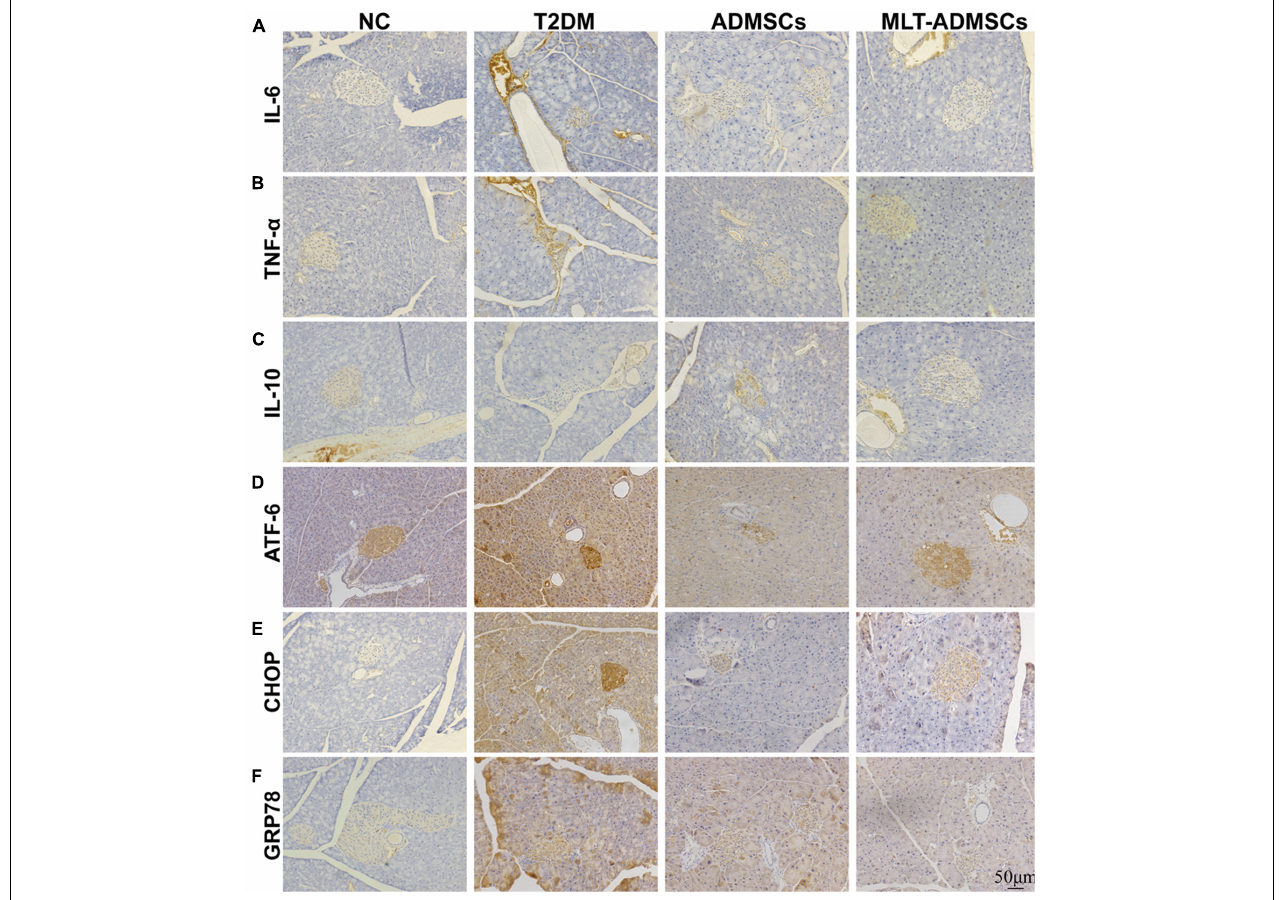
FIGURE 5 | MLT promotes the therapeutic effect of ADMSCs through stronger anti-inflammatory and anti-ER stress abilities to restore pancreatic islet function. (A) Pancreatic IL-6 expression. (B) Pancreatic TNF- α expression. (C) Pancreatic IL-10 expression. (D) Pancreatic ATF-6 expression. (E) Pancreatic CHOP expression. (F) Pancreatic GRP78